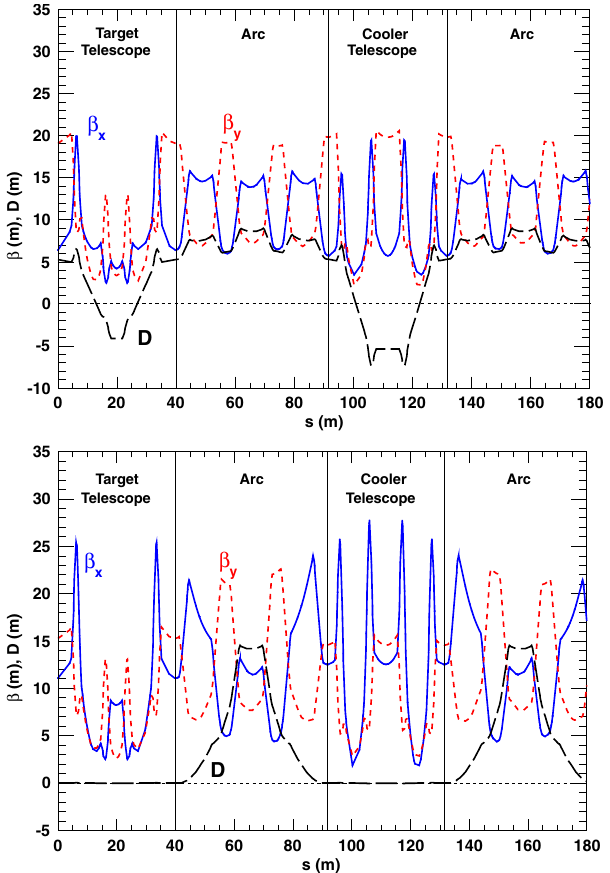
; β ) and dispersion D x y